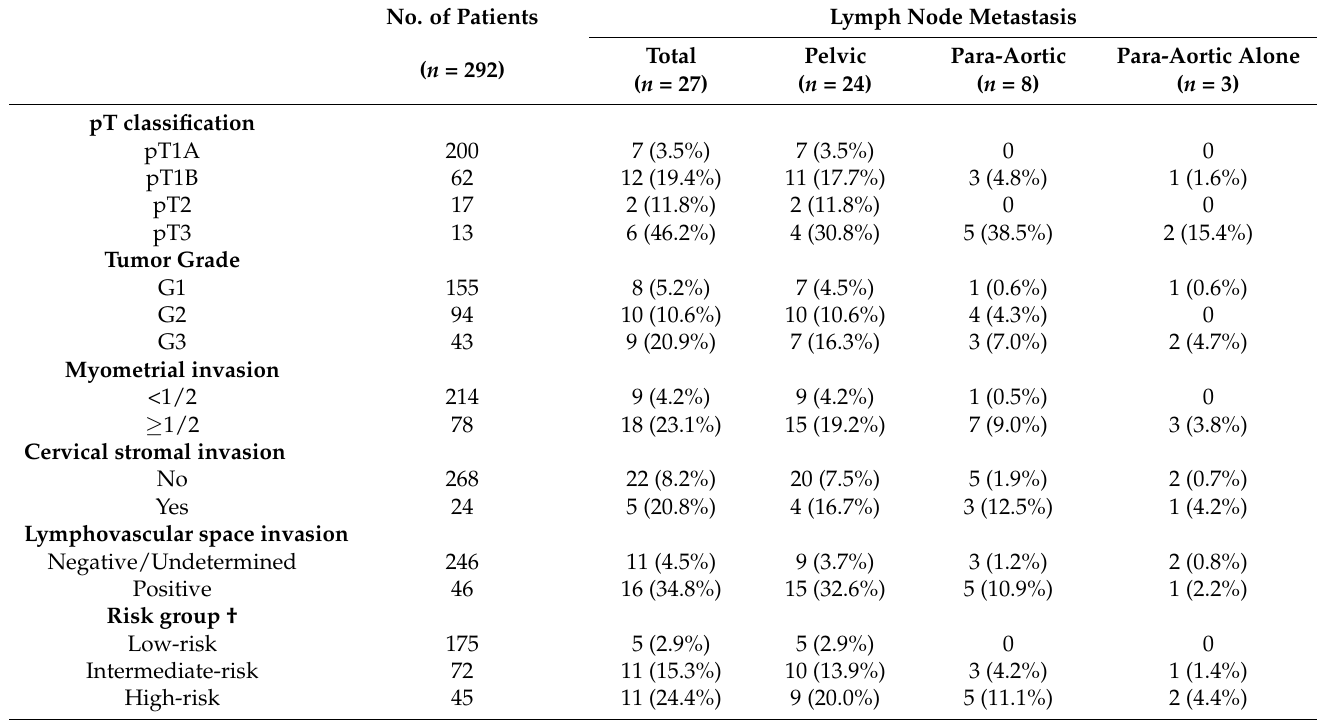
Table 1. Incidence of lymph node metastasis by various surgical-pathological